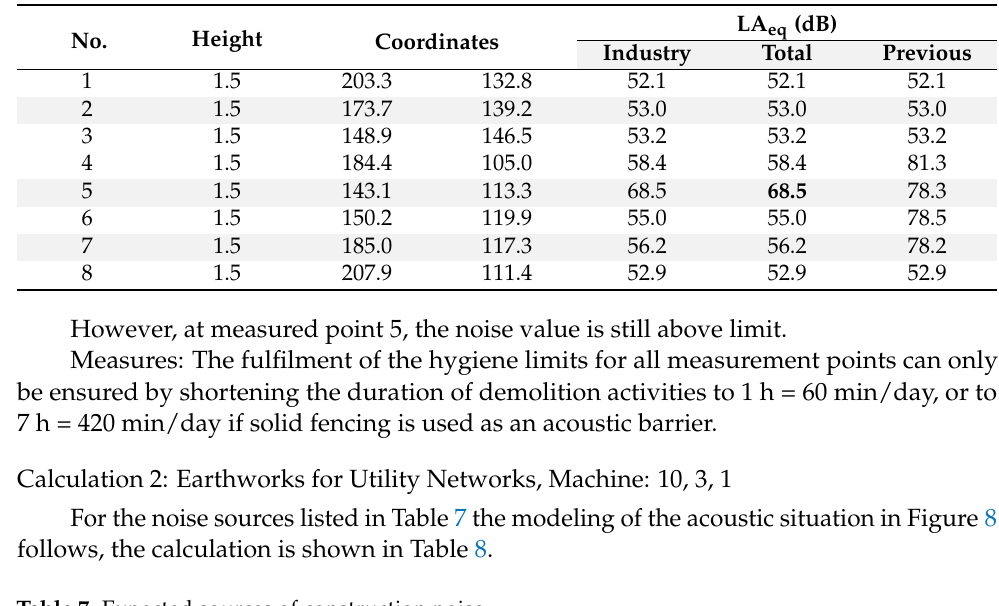
Table 7. Expected sources of construction noise.